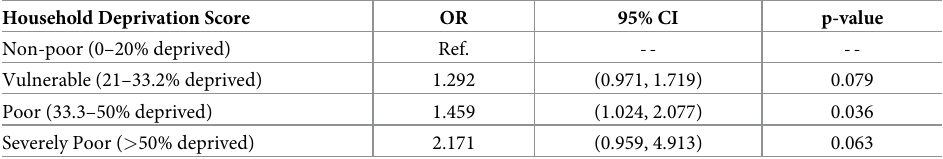
Table 6. Poverty status and PHQ-8 depressive